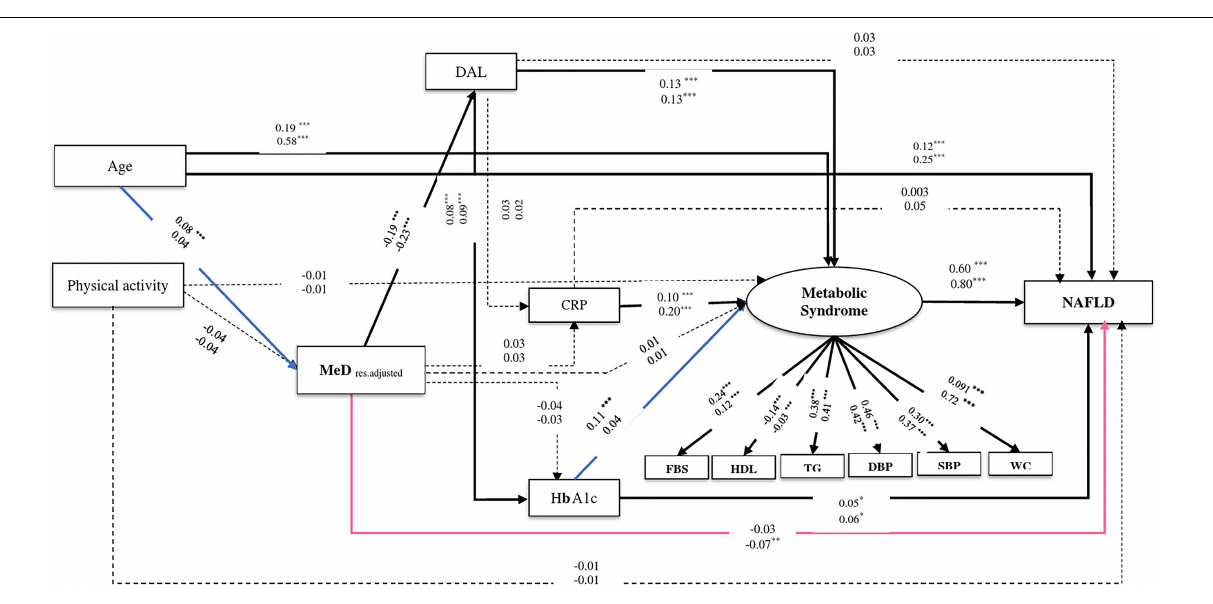
FIGURE 4 | The final structural model of the relationship between residual adjusted MeD and NAFLD. The model fit indices: χ 2 /df = 5.21, p < 0.001, GFI = 0.98, AGFI = 0.96, CFI = 0.95, IFI = 0.95, SRMR = 0.03, RMSEA = 0.03. The values on the paths represent standardized regression coefficients. The upper-faced numbers refer to males, whereas the numerical values below them refer to females. Arrows in bold represent statistically significant associations ( ∗ P < 0.05; ∗∗ P < 0.01; ∗∗∗ P < 0.001). Pink arrows refer to females whereas blue arrows refer to